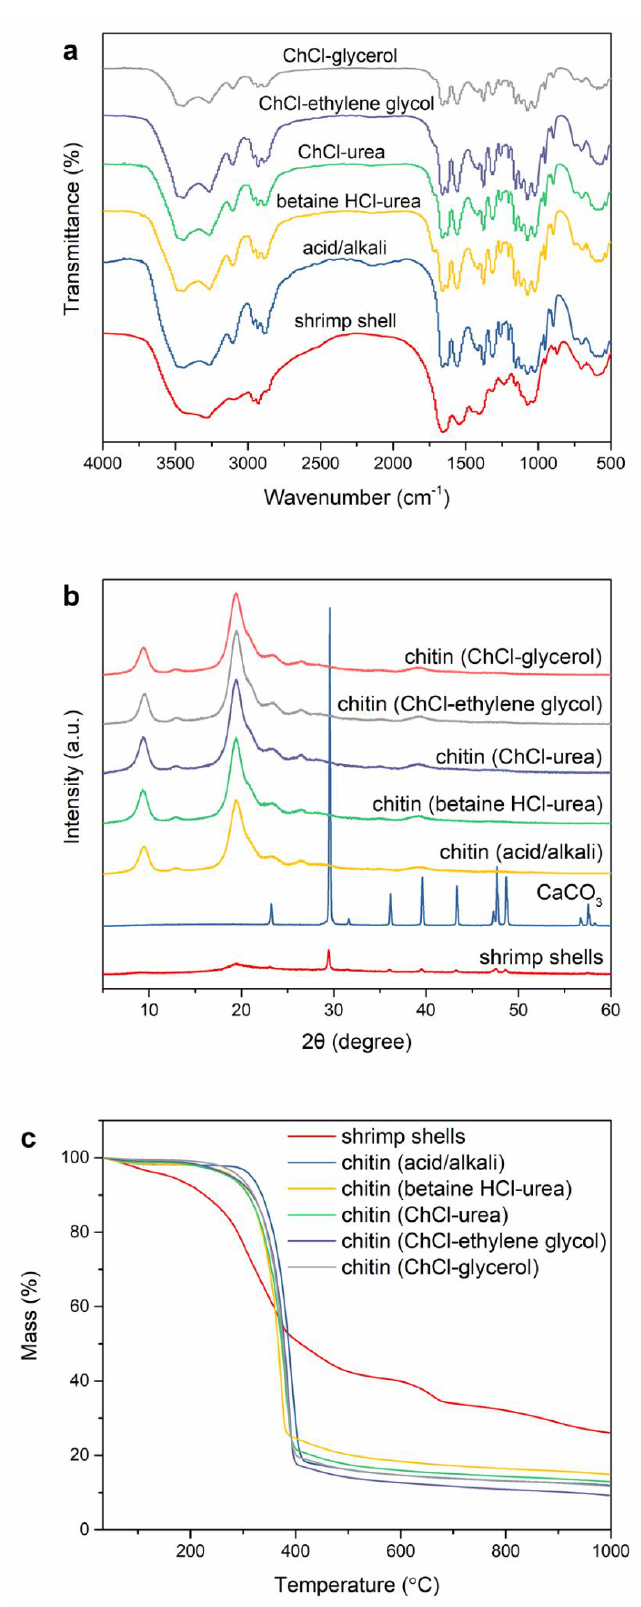
Figure 4. ( a ) FT-IR spectra of shrimp shells, acid/alkali-prepared chitin, and DES-prepared chitin; ( b ) XRD curves of the shrimp shells, CaCO 3 , acid/alkali-prepared chitin, and DES-prepared chitin; and ( c ) TG curves of the shrimp shells, acid/alkali-prepared chitin, and DES-prepared